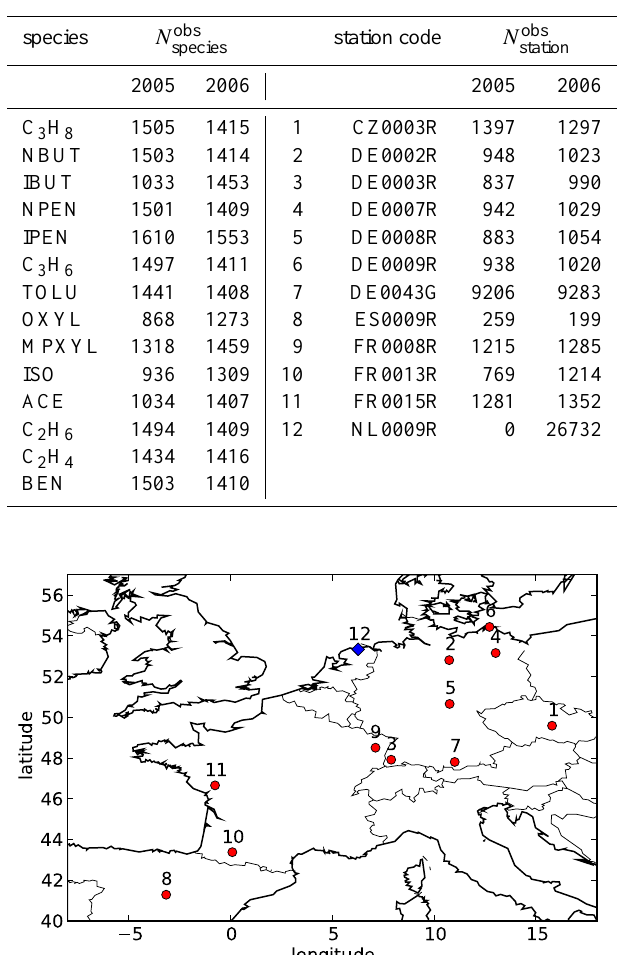
Table 2. Number of observations for each species ( N obs number of observation dates for each station ( N obs bers 1–12 are given to help locate the stations on the map of Fig. 1.